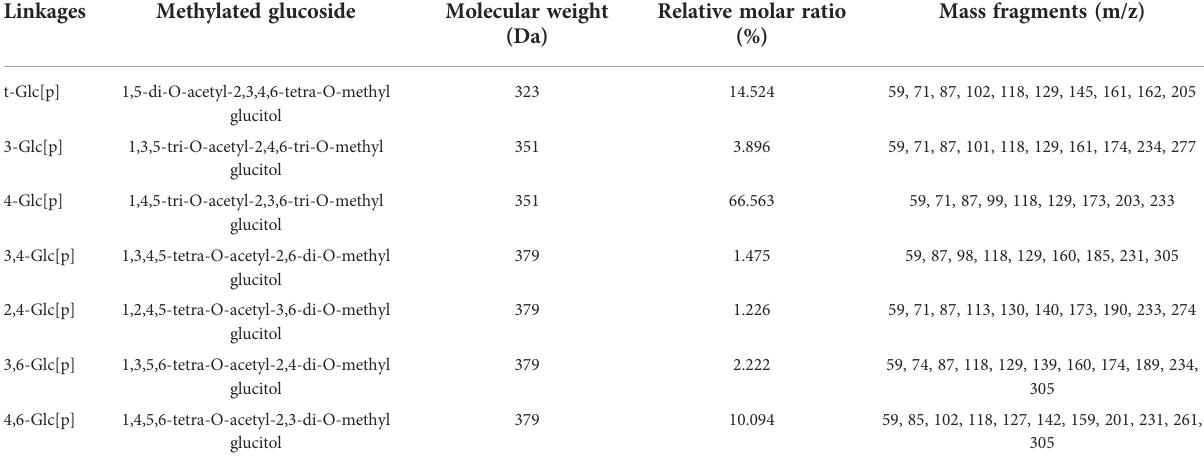
TABLE 1 Methylation analysis of GFPA.